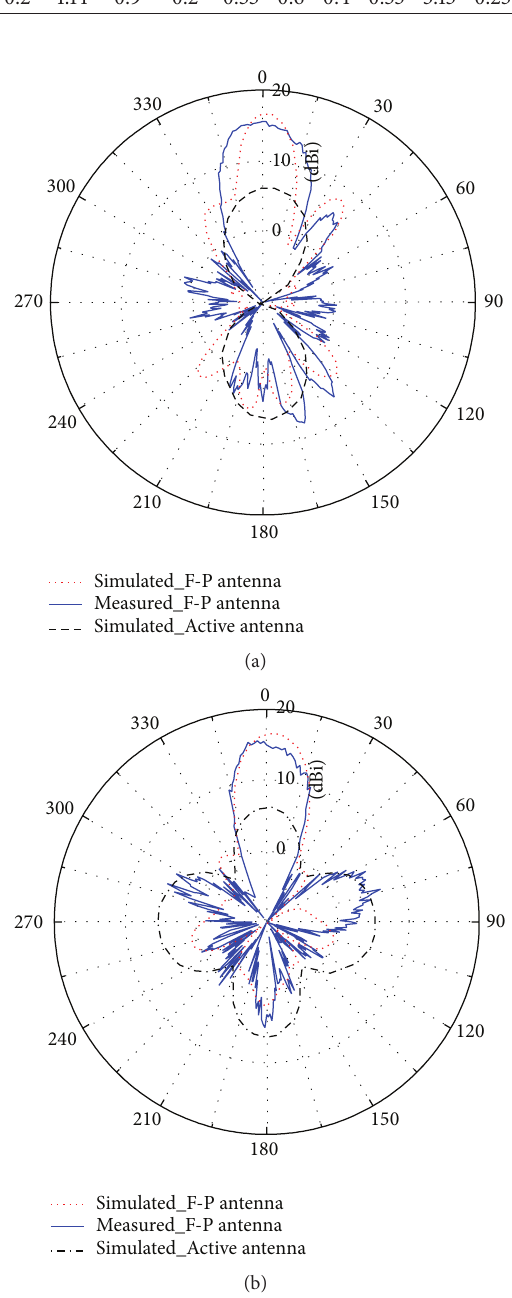
Figure 11: Measured and simulated radiation patterns of (a) E-plane ( 𝑦𝑜𝑧 ) and (b) H-plane ( 𝑥𝑜𝑧 ) at 35